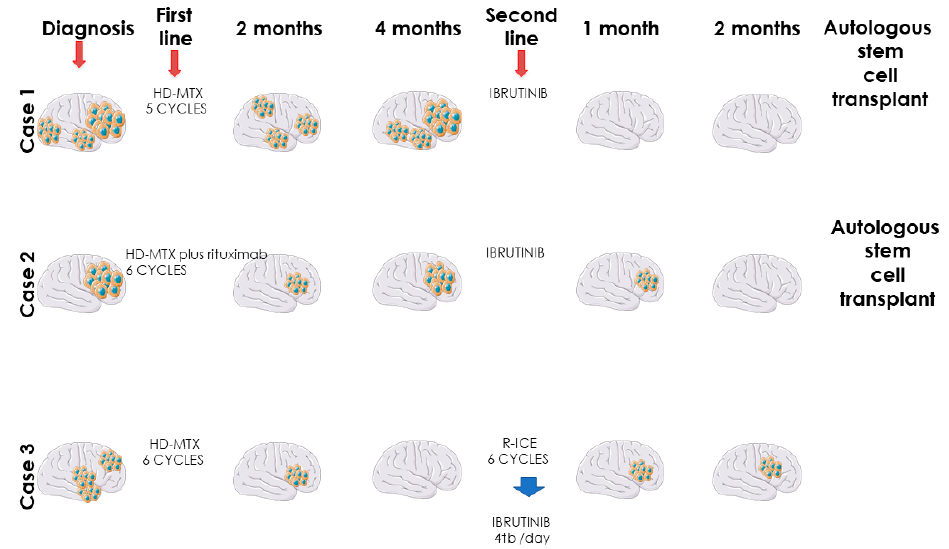
Figure 1. Overall clinical evolution of primary CNS lymphomas treated with ibrutinib.